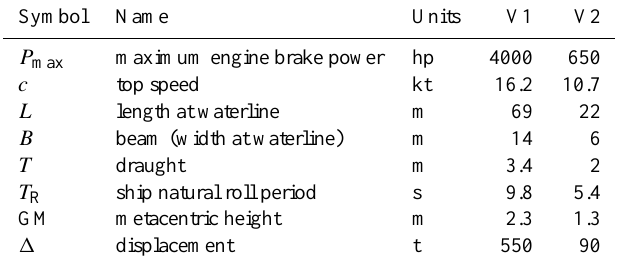
Table 5. Database of vessel propulsion parameters and principal particulars used in this work. See Fig. 3 for the meaning of the geo- metrical parameters. V1 is a ferryboat while V2 is a fishing vessel. Most data stem from www.marinetraffic.com; T R is estimated from the metacentric height GM using Weiss’ method for small roll an- gles as reported in Benedict et al. (2004) and adding an extra 20% to account for roll stabilization. Metacentric height is assumed to be GM 2 T/ 3. (cid:49) is not used by VISIR-I and is provided just for the = sake of